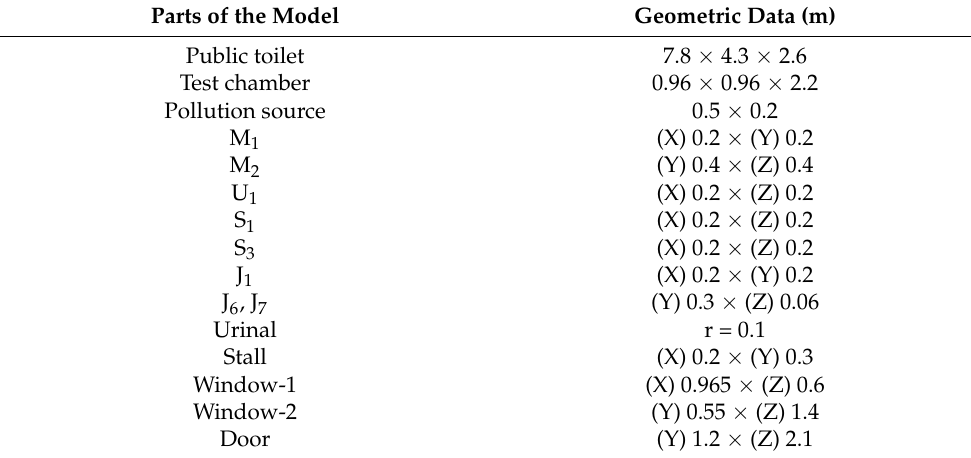
Table 1. Geometric data.